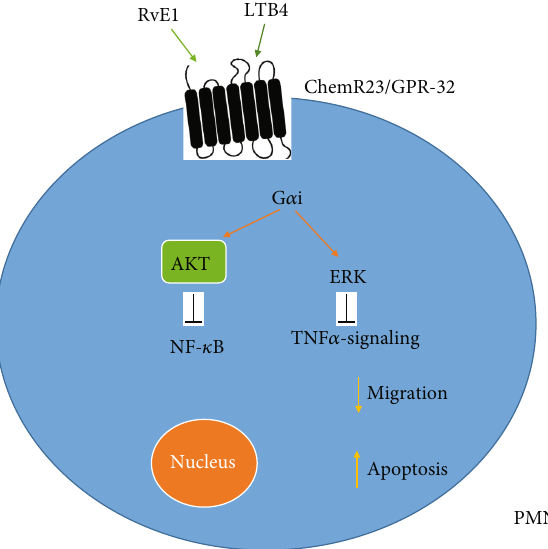
Figure 4: RvE1 blocks NF- κ B and TNF α -signaling pathways through binding to ChemR23 (chemerin 23) receptor, induces apoptosis, and decreases migration. AKT: protein kinase B; ERK: extracellular signal-regulated kinases; RvE1: resolvin